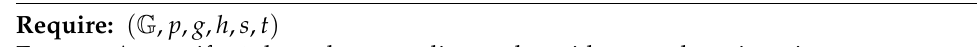
Algorithm 2 DL-based Σ